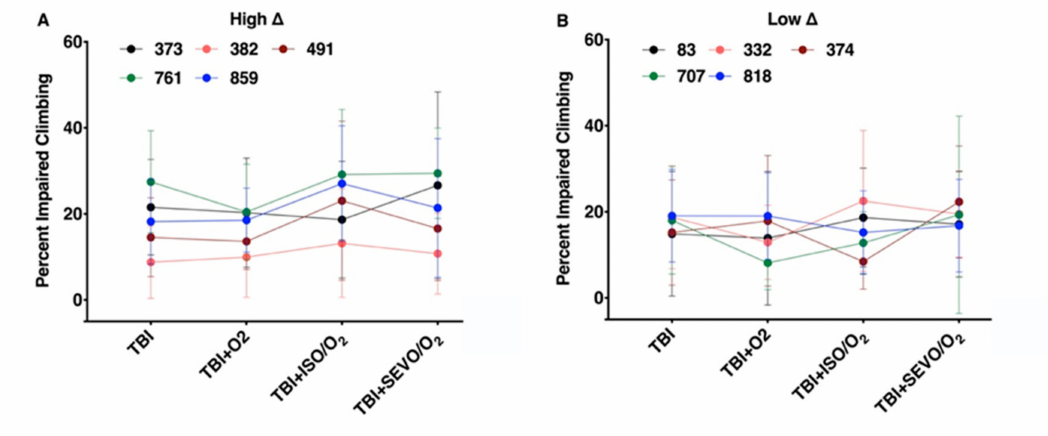
Figure A16. Climbing of individual RAL lines at 48 h. See Figure 7 for